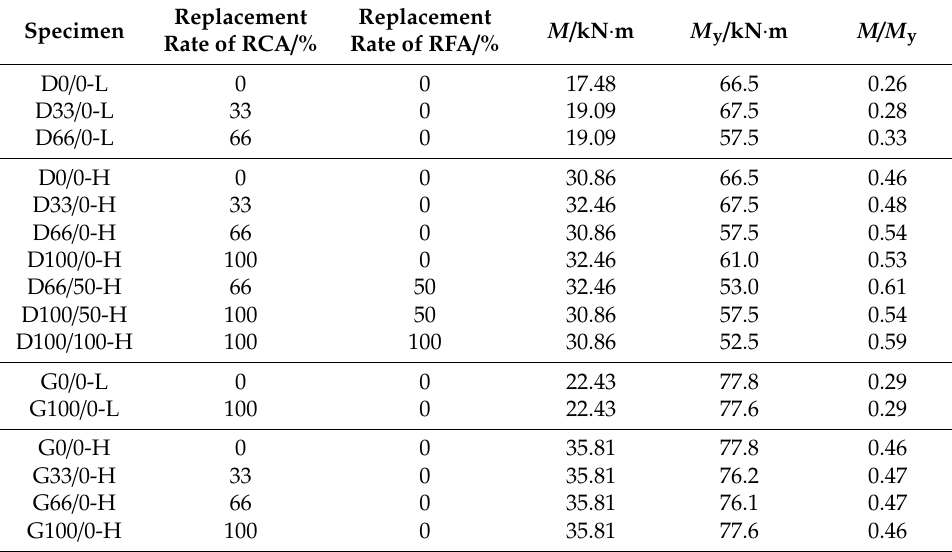
Figure 1. Dimensions and reinforcement of the specimen (unit: mm). Table 1. Number of specimens and stress ratio